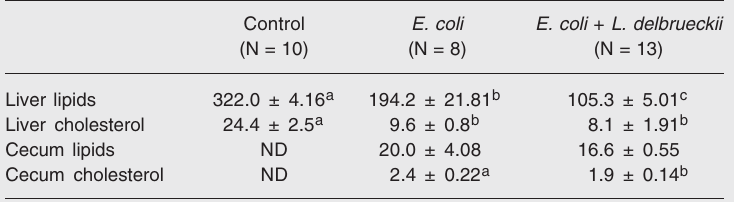
Table 1. Total lipids and cholesterol in liver and cecum of NIH mice colonized with Escherichia coli or E. coli and Lactobacillus delbrueckii for 4 weeks or maintained axenic (control).